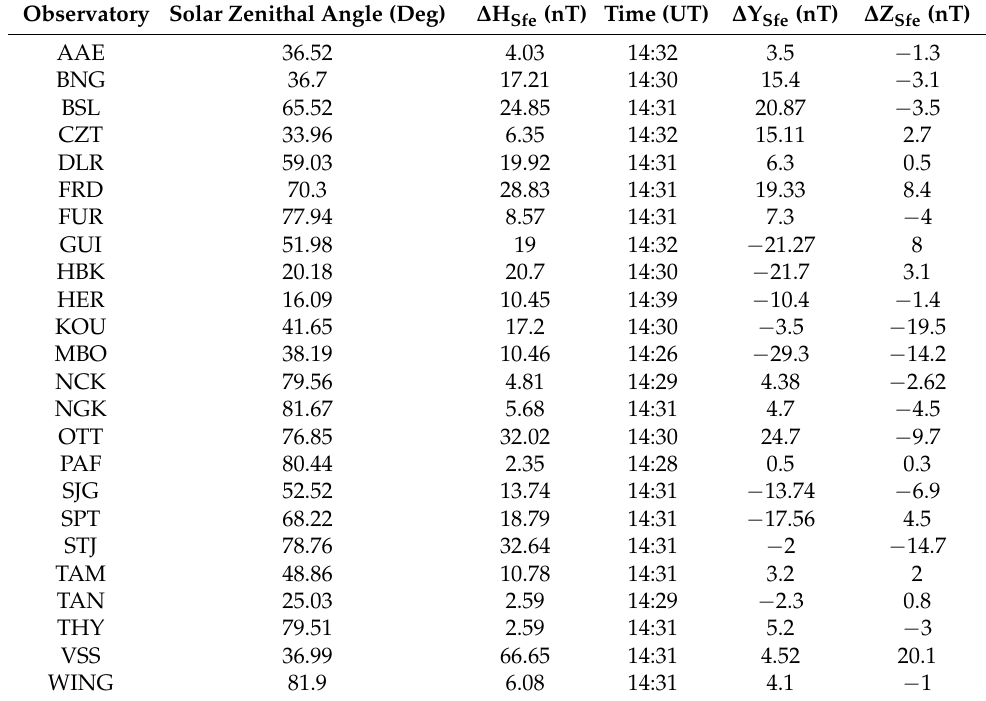
Table 7. The magnetic observatories data of solar flare X6.4 of 13 December 2001. Observatory Solar Zenithal Angle